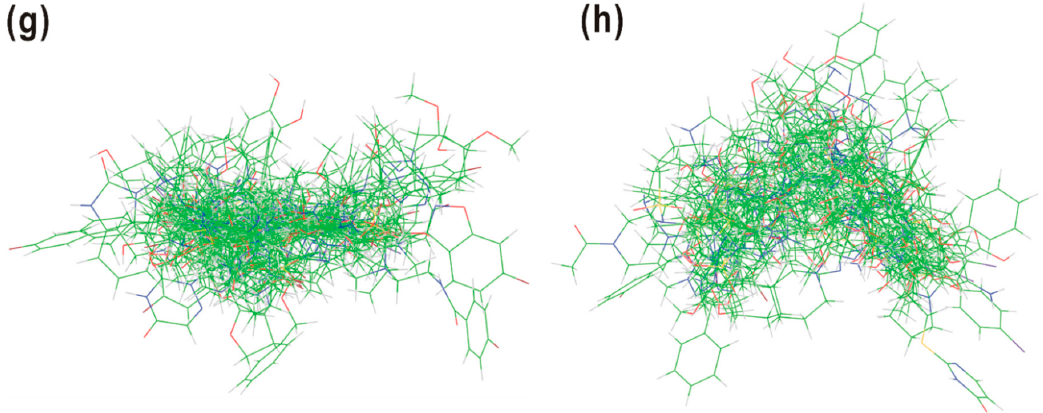
Figure 2. The results of 3D structural alignments among the molecules in ( a ) Subset 1, ( b ) Subset 2, ( c ) Subset 3, ( d ) Subset 4, ( e ) Subset 5, ( f ) Subset 6, ( g ) Subset 7, and ( h ) Subset 8. Carbon, hydrogen, nitrogen, and oxygen are indicated in green, gray, blue, and red, respectively.